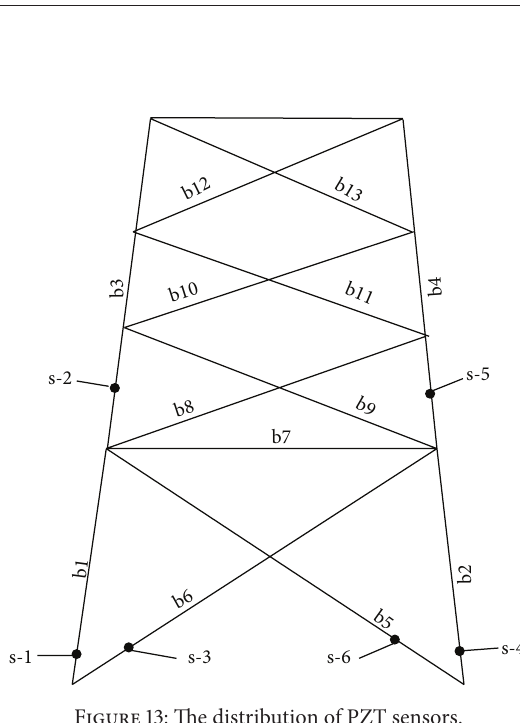
Figure 13: The distribution of PZT